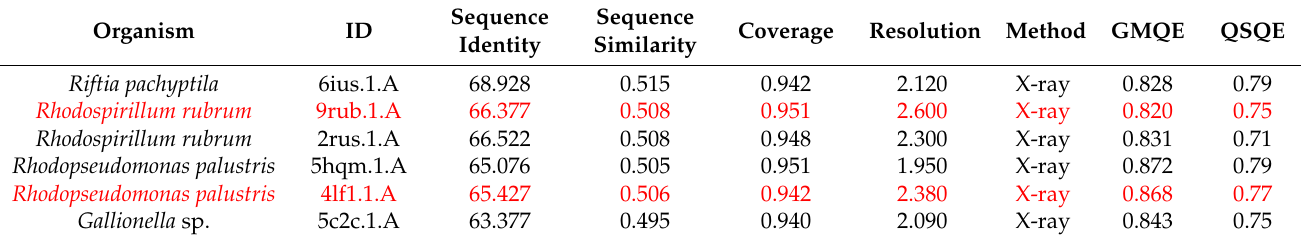
Table 3. Templates with highest homology parameters obtained with SWISS-MODEL. The models were built on the templates marked in